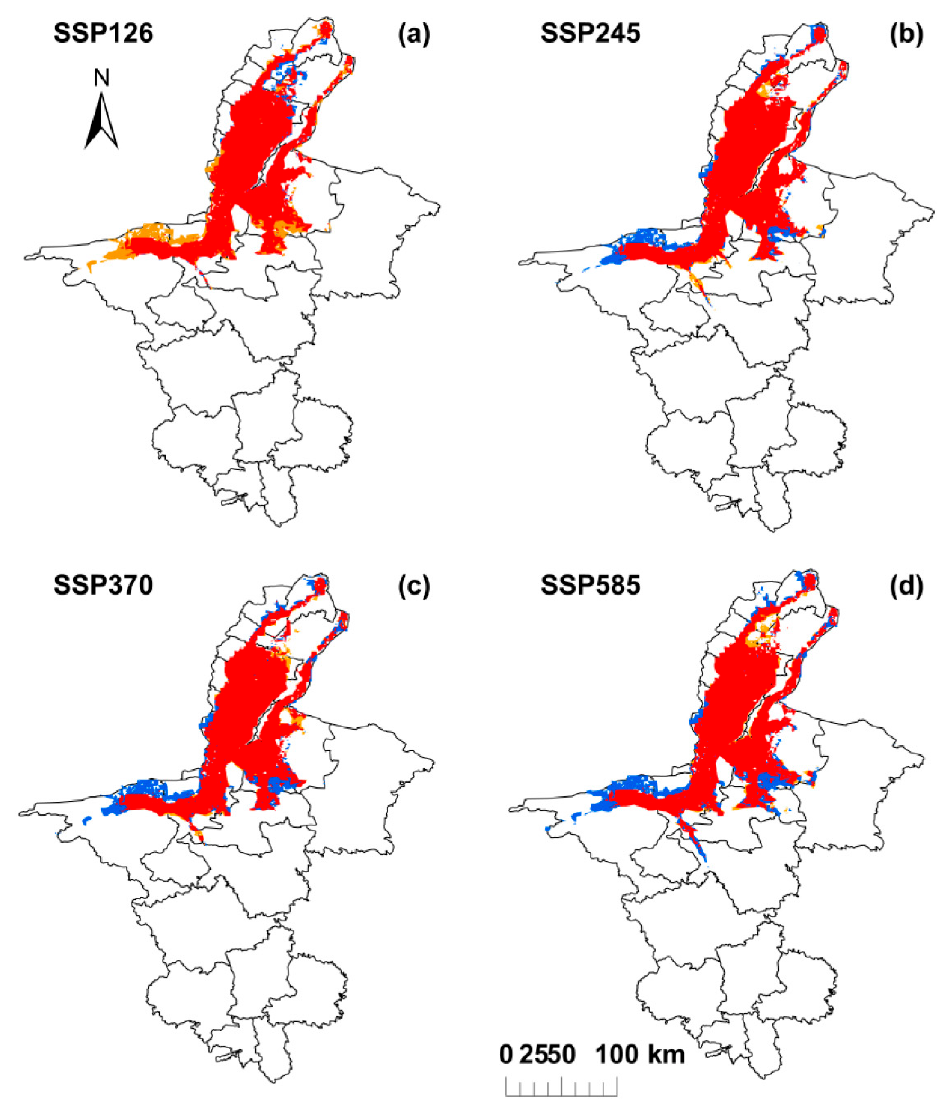
Figure 7. The potential suitable areas for wine grapes under SSP126 ( a ), SSP245 ( b ), SSP370 ( c ), and SSP585 ( d ) during the period of 2001–2060 in Ningxia. Red represents potential suitable areas of wine grape with long-term sustainability (current–2060). Orange represents potential suitable areas of wine grape with short-term sustainability (suitable only from current period to 2040). Blue represents new suitable areas of wine grape, which are not currently suitable but will be suitable over the next 38 years. Table 4. The potential suitable areas for wine grape during four periods under four emission scenarios in